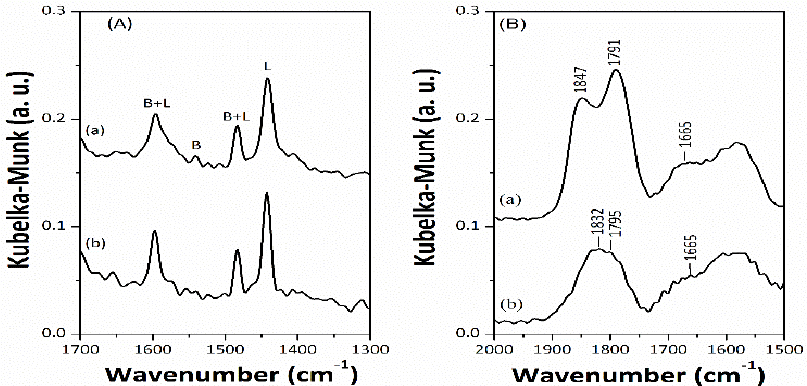
Figure 3. In situ diffuse reflectance infrared Fourier transform (DRIFT) spectra of ( A ) pyridine and ( B ) NO adsorbed on mesoporous sulfide catalysts (a) CoMo/γ-Al 2 O 3 and (b) NiMo/γ-Al 2 O 3 . The B and L represent the Brønsted and Lewis sites, respectively.